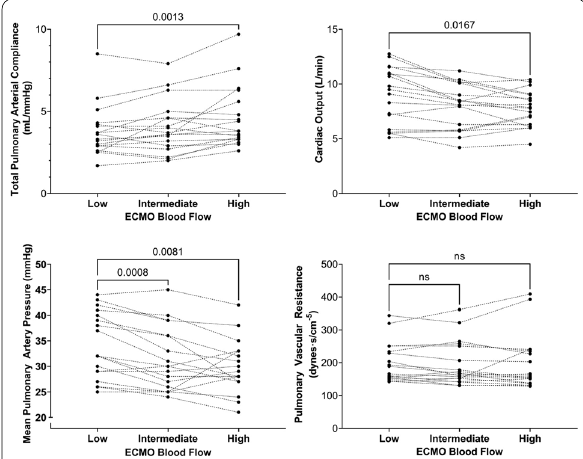
Figure 1: ANOVA p 0.0006 for total pulmonary arterial compli- = ance, p 0.0027 for cardiac output, p 0.0024 for mean pulmonary = = artery pressure, and p 0.8175 for pulmonary vascular resistance. = Tukey’s correction is applied for multiple